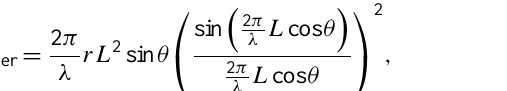
normal to the slant surface, extremely directive in the ver- tical plane and omnidirectional in the horizontal plane. The scattering from the mast can be approximated by the RCS of a right circular cylinder, which will be the basis of the pro- posed model for calculating the wind turbine RCS values, as later described in Sect. 5.1.